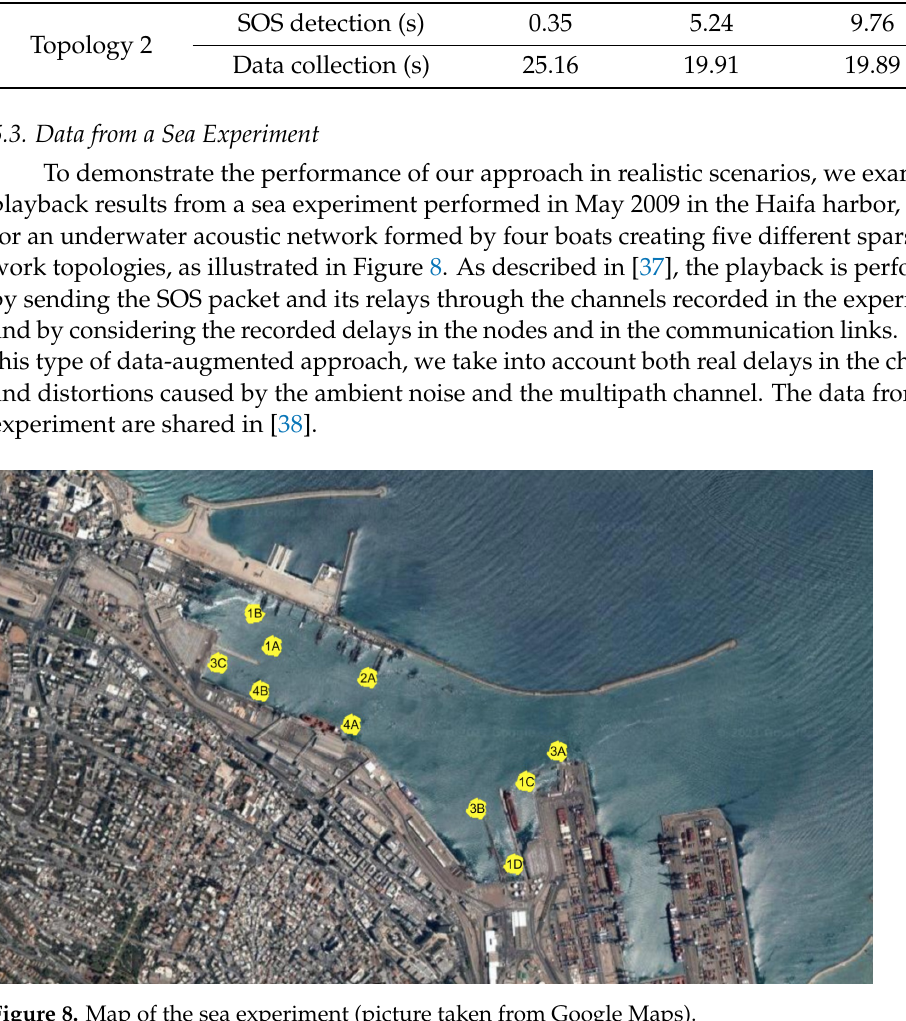
Figure 8. Map of the sea experiment (picture taken from Google